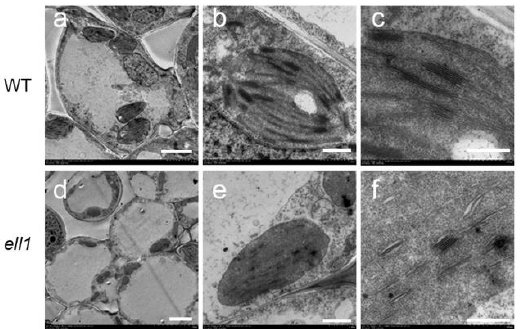
Figure 3. Electron micrographs of chloroplasts from the wild-type and ell1 mutant. Chloroplasts from three-day-old wild-type (WT) and ell1 plants observed by transmission electron microscopy. Magnified views (for ( a , d ), bars = 5 µ m; for ( b , e ), bars = 1 µ m; for ( c , f ), bars = 0.5 µ m) are shown on the right.